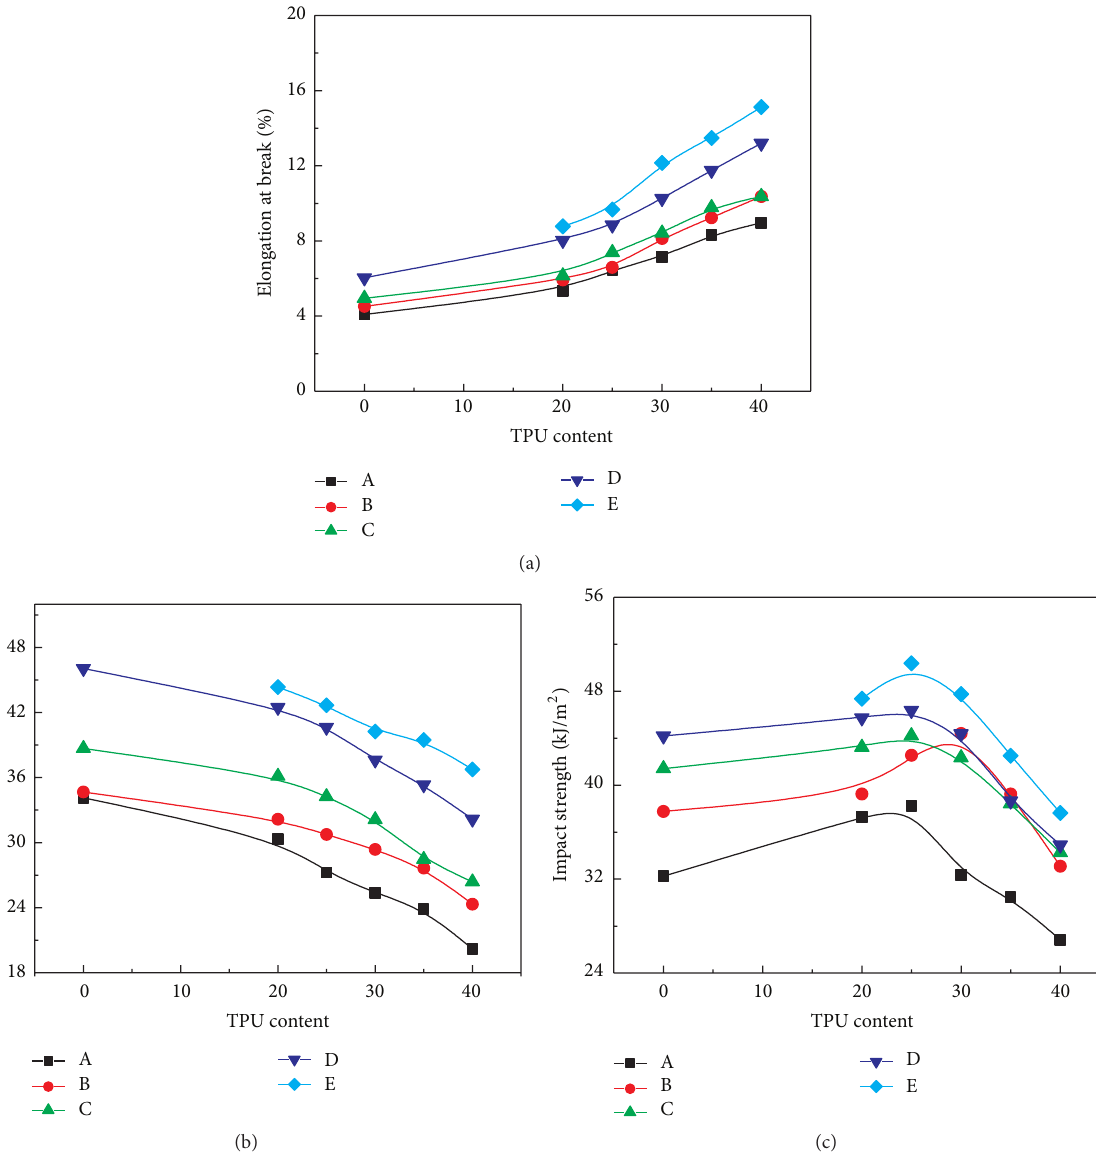
Figure5:MechanicalpropertiesofPC/PLA/TPUblends(A:PC/PLA=50/50;B:PC/PLA=60/40;C:PC/PLA=65/35;D:PC/PLA=70/30;E: PC/PLA/DBTO = 70/30/0.8; TPU content is the ratio of copies, e.g., in image (a); TPU content = 30 corresponds to PC/PLA/TPU = 50/50/30 (mass